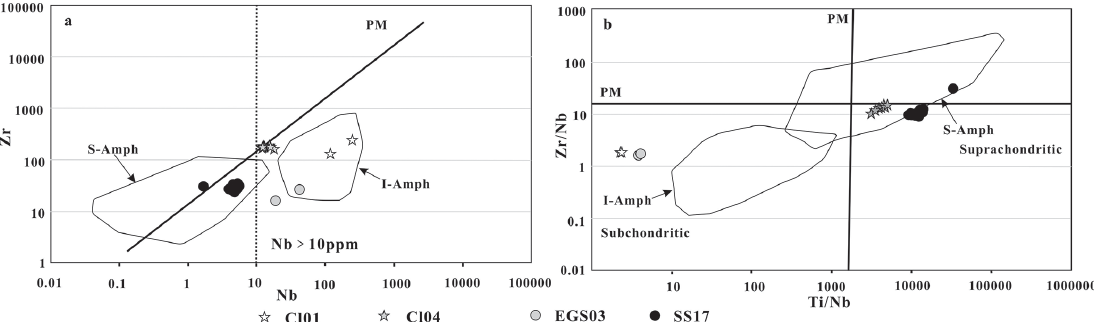
Figure 12. Diagrams of Zr versus Nb and Zr / Nb versus Ti / Nb of Changle rhönite modified after Coltorti et al. (2007b); PM is primordial